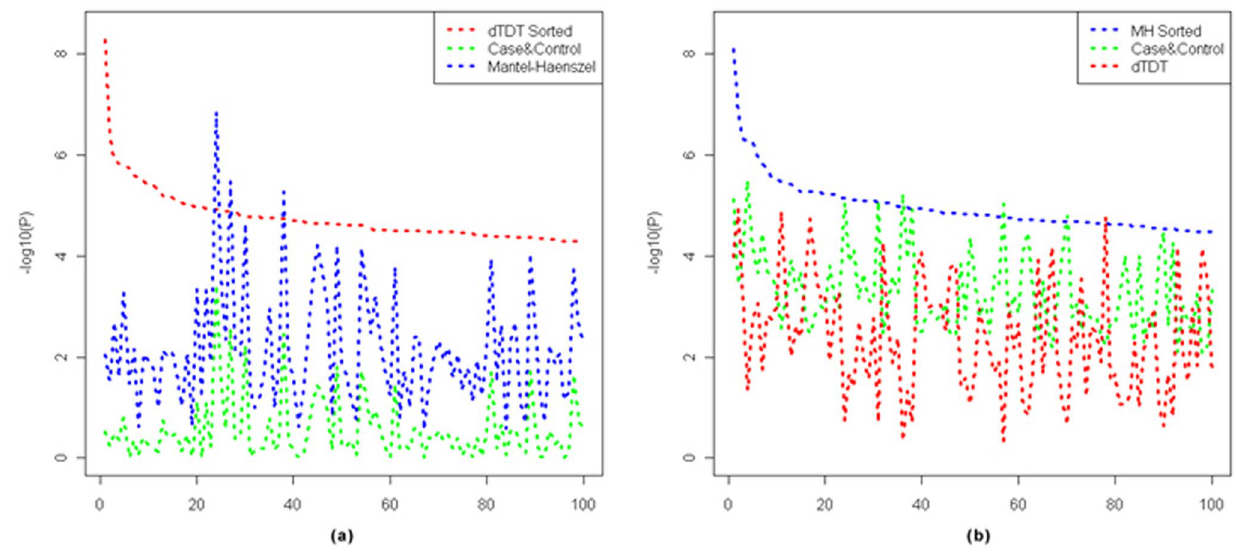
Figure 8. Line chart of top 100 signals from Case-Control, dTDT and MH tests. (a) line chart ranked by -log 10 ( p-value ) from dTDT and its corresponding